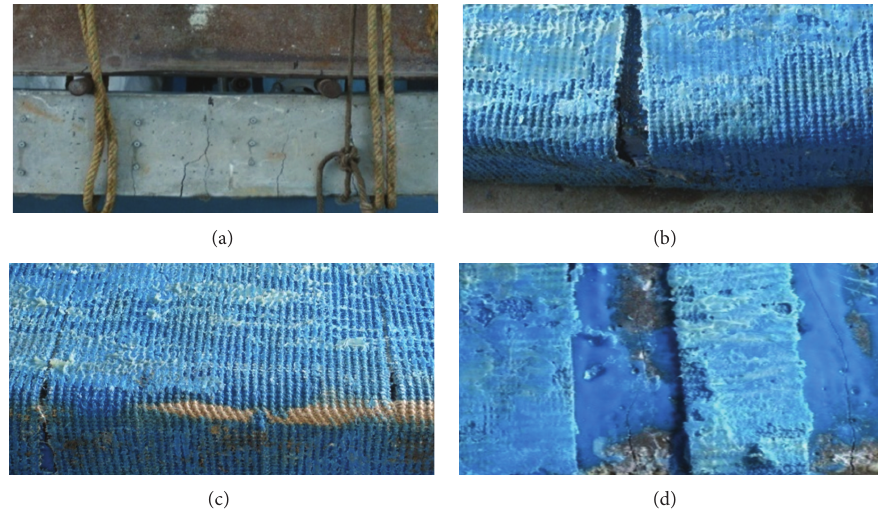
Figure 7: (a) Control beams (group A, Con1) under load; (b) formation of flexure crack in the beam JF1, under load; (c) formation of flexure crack in the beam JF2, under load; (d) formation of flexure crack in the beam JF3, under